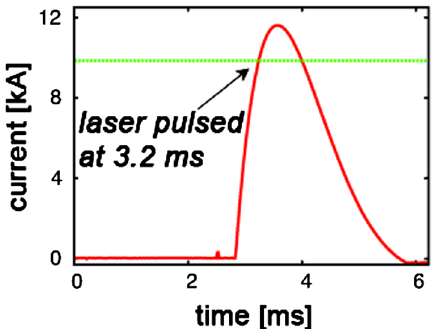
FIG. 5. Plot of measured current through the solenoid as a function of time. The solenoid is pulsed at time t ¼ 2 : 85 ms , and the laser is pulsed at t ¼ 3 : 20 ms . The current at the time of the laser pulse is 9.85 kA as indicated by the green dashed line and can be considered static since the acceleration time is on the ps time scale and propagation time through the magnetic field is on the ns time scale.